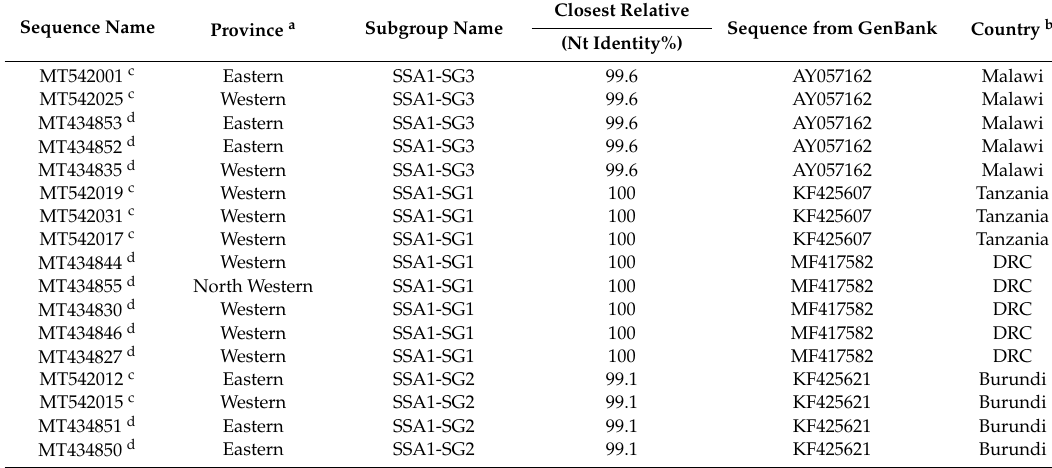
Table 2. Comparison of the selected genetic groups from Zambia to the sequences in